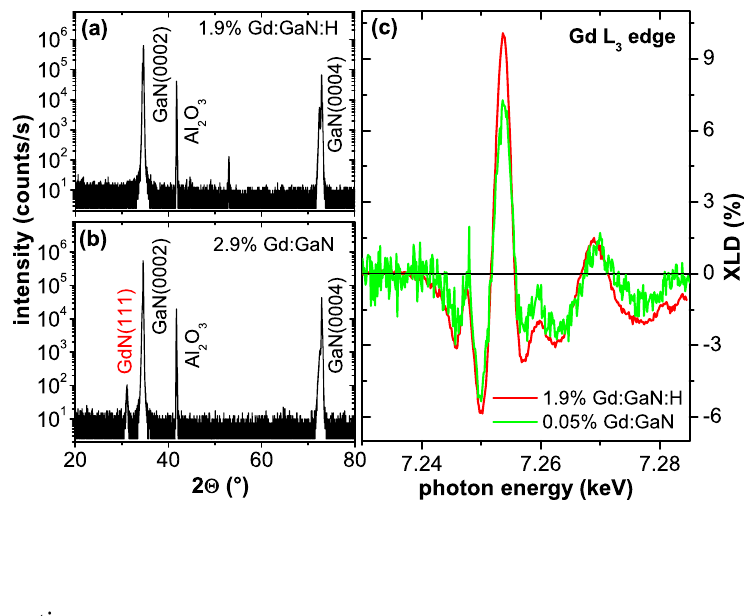
Figure 17. XRD ! -2 (cid:18) -scans (a) for the 1.9% Gd:GaN sample co-doped with H with no signatures of phase separation and (b) for the 2.9% Gd:GaN sample clearly revealing a secondary phase identified as GdN. (c) XLD spectra recorded at the Gd L -edge of the 1.9% Gd:GaN:H (red) and the 0.05% Gd:GaN (green) 3